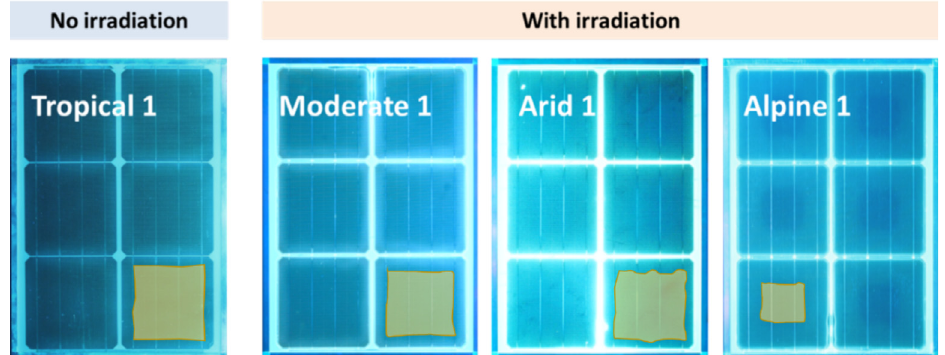
Fig. 8. Comparison of UVF-images of test modules after 1000 h of accelerated aging (procedures with and without additional irradiation); exemplarly speci fi c UVF pattern is highlighted in yellow for each module